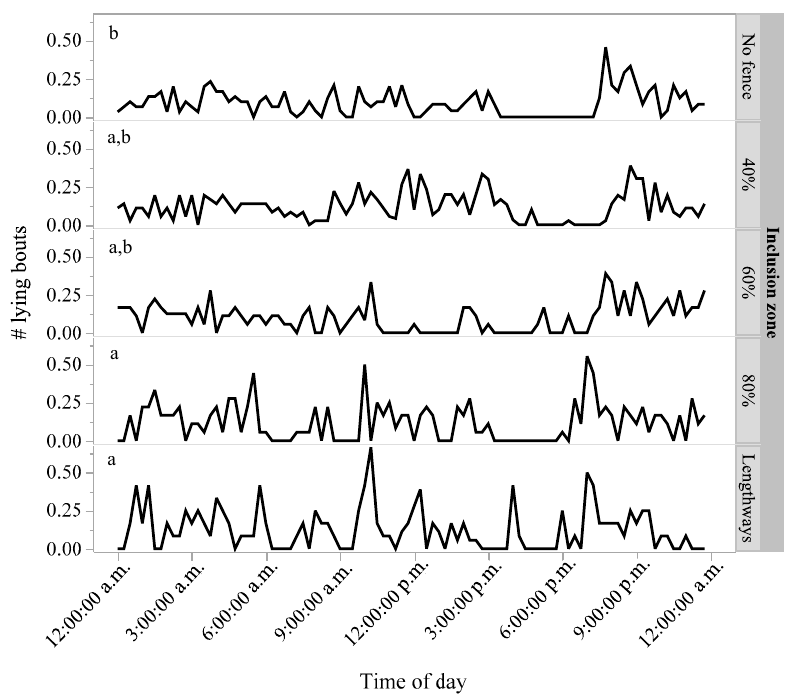
Figure 5. Mean number of lying bouts within 15-min sample intervals throughout the day, averaged across six heifers for each of the different virtual fence inclusion zones (no fence, 40%, 60%, 80%, and lengthways). a,b Superscript letters indicate significant differences in the number of lying bouts between inclusion zones ( p < 0.01).